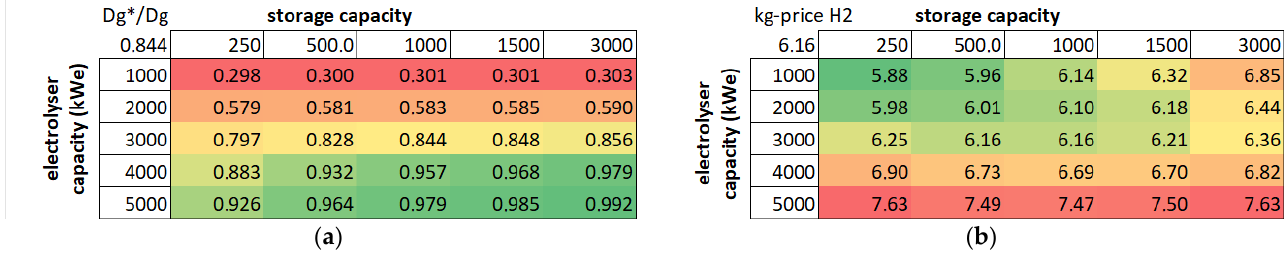
Figure 6. Influence of electrolyser and storage capacity on ( a ) supply security and ( b ) hydrogen price. Figure 6 indicates that the storage capacity chosen could be smaller at 500 or 1000 kg.